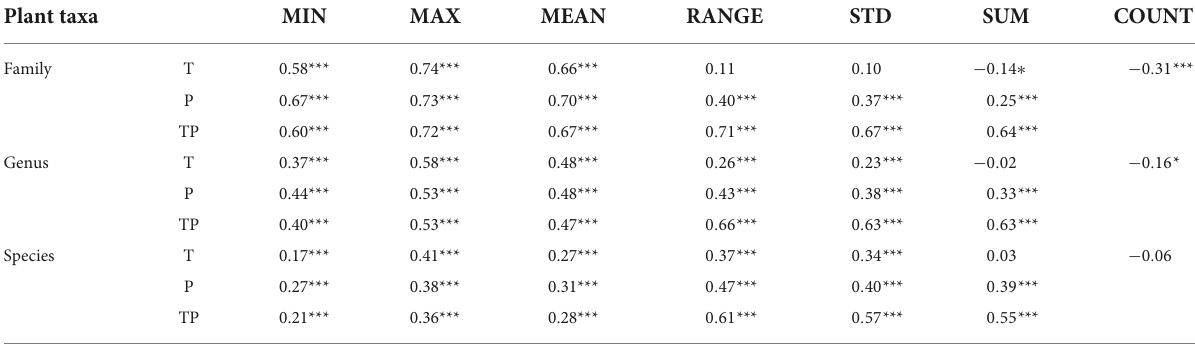
TABLE 1 Correlation between the diversity patterns of plant families, genus, and species and climatic factors. Plant